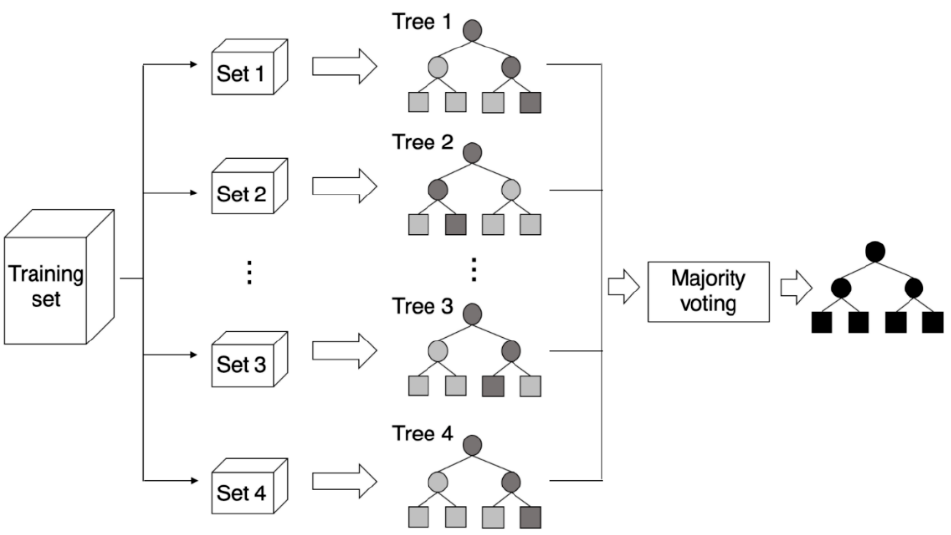
Figure 1. The concept of random forest, source: Yim [31].